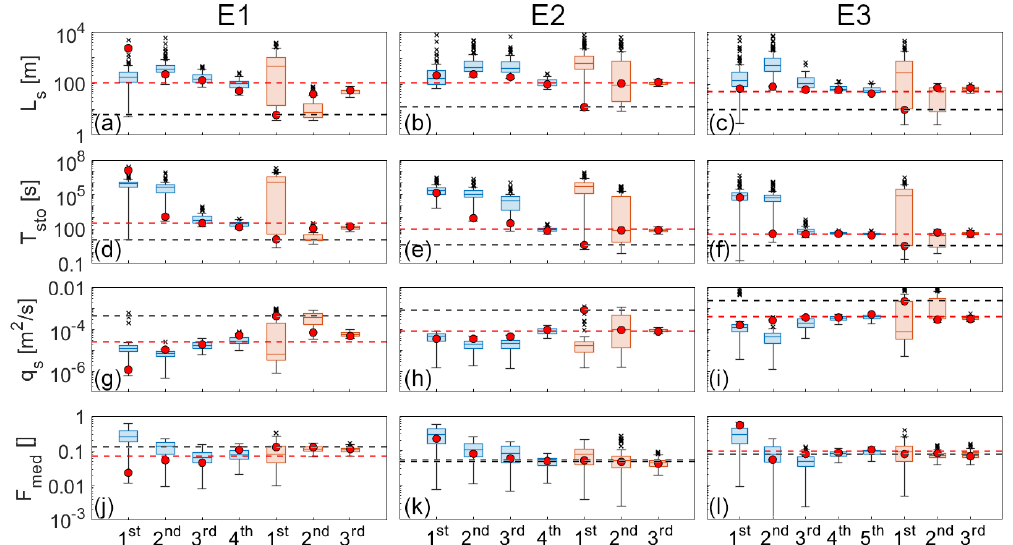
Figure 7. Boxplots of the investigated transport metrics for the 100 best parameter sets for the three simulated experiments. (a–c) L s , (d– f) T sto , (g–i) q s , (j–l) F med . Results are reported for (a, d, g, j) E1, (b, e, h, k) E2, and (c, f, i, l) E3. On the x axis, we indicated the n th TSM iteration. Blue and orange boxplots indicate results when velocity was a varying model parameter and when it was kept fixed and equal to v peak respectively. Red dots indicate the transport metric values obtained via the parameter sets with a lower RMSE. The red and black horizontal dashed lines indicate respectively the transport metric obtained using the OTIS-P results and OTIS-MCAT results (the first TSM simulation when velocity was kept fixed and equal to v peak